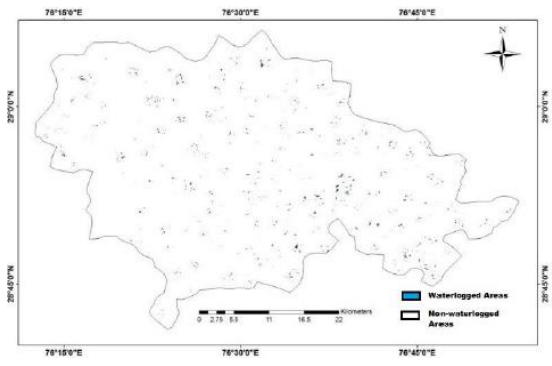
Fig 9: 500 m buffer around the canal network